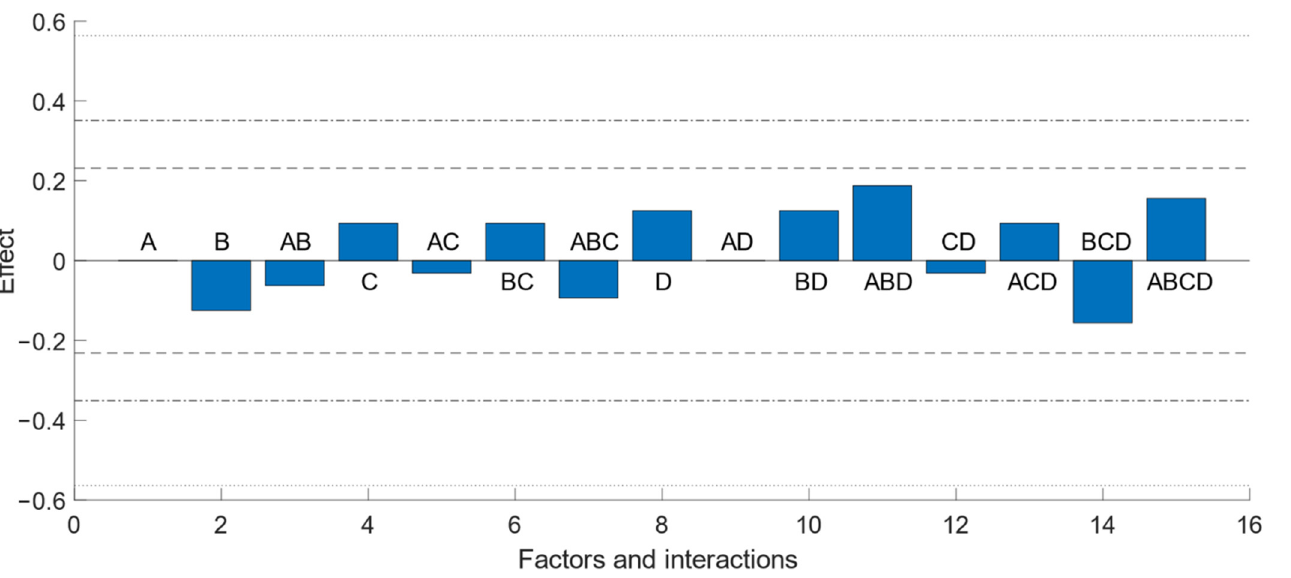
Figure 6. Effects of factors and their interactions within confidence intervals.